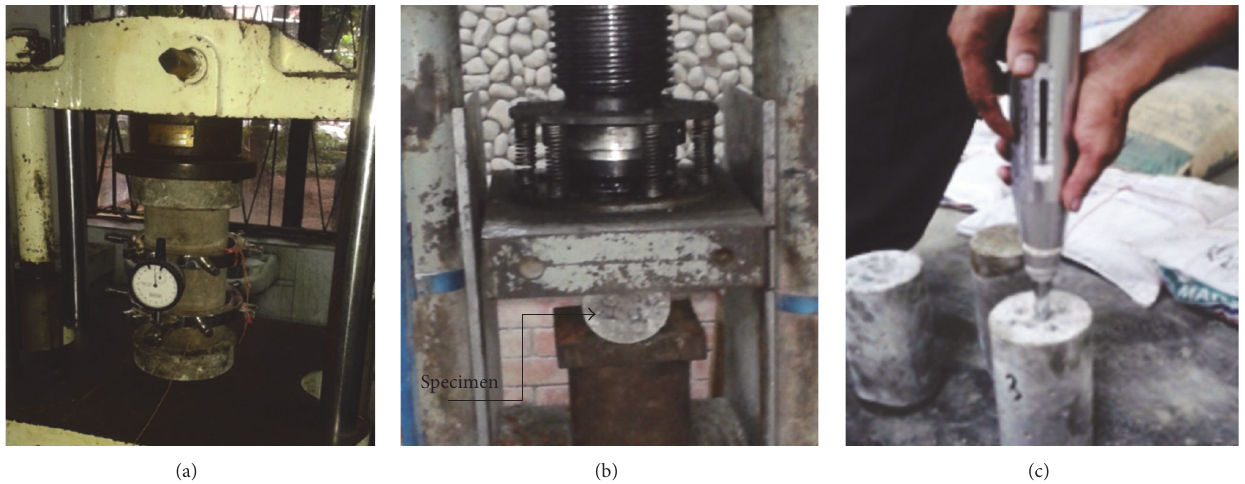
Figure 4: (a) Compressive strength and stress-strain test, (b) tensile strength test, and (c) nondestructive